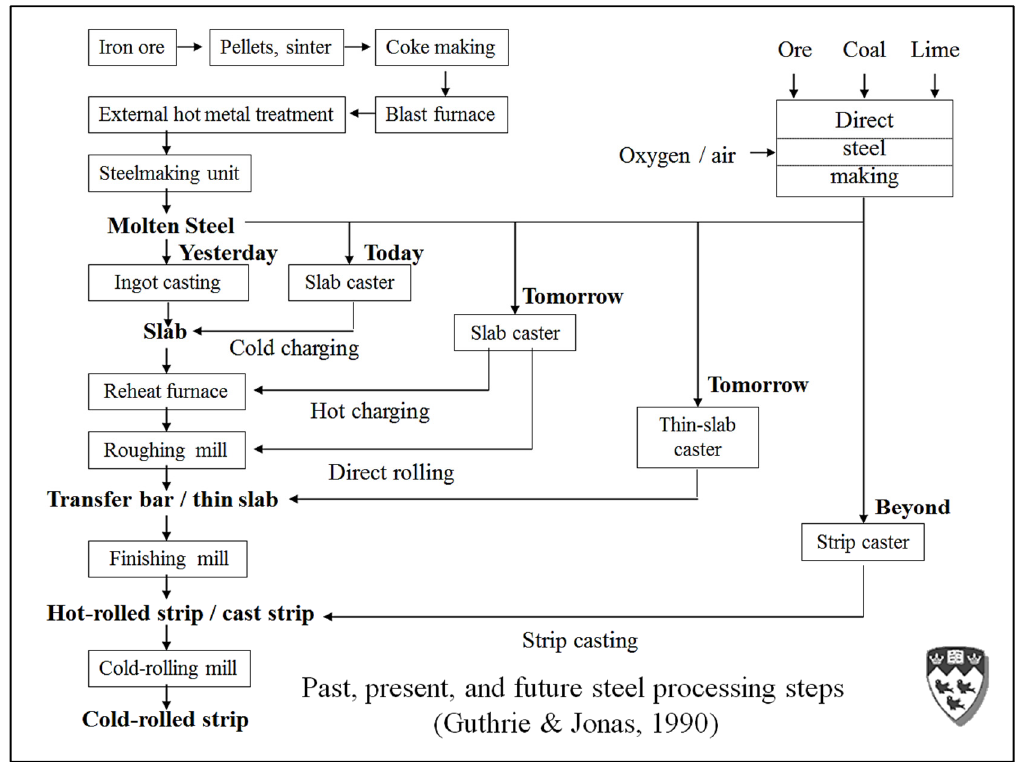
Figure 1. The past, present, and future of steel processing steps, as predicted in 1990